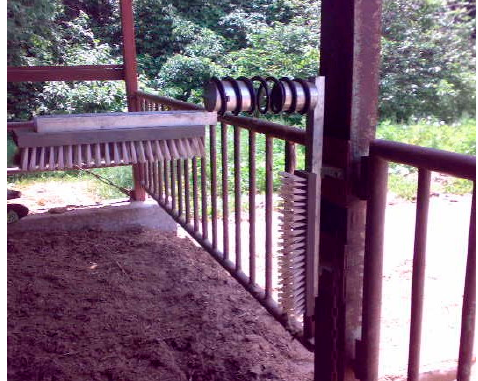
Figure 1. Grooming device (brush) used in this study.